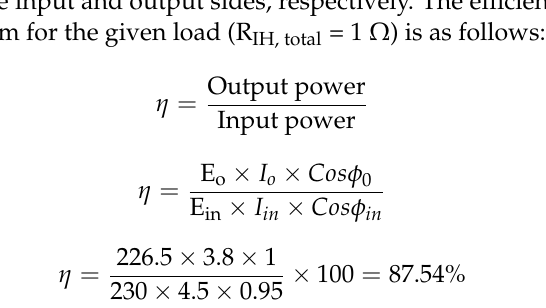
Figure 24. Output Voltage of (DC link voltage): ( a ) MVR simulation result; ( b ) MVR experimental result; and ( c ) conventional VR simulation result.